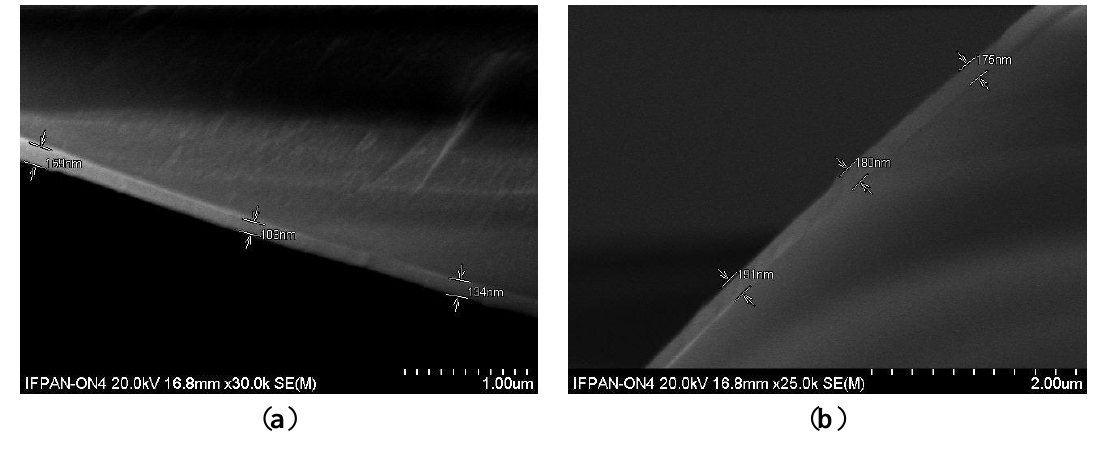
Figure 2. Cross-section of the optical fibers with deposited Al thicknesses for ( a ) and ( b ) films on reference Si samples are 127 and 177 nm,